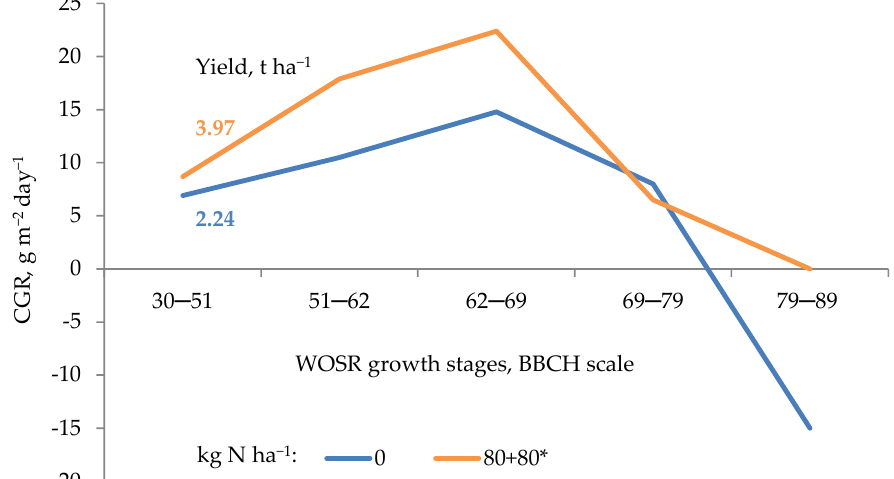
Figure 4. Crop growth rate (CGR) of winter oilseed rape (WOSR) during the growing season as affected by nitrogen fertilizer (based on Barł ó g and Grzebisz [22]). Key: CGR—crop growth rate, N–0—absolute control, N–80 + 80*–N rate of 160 kg N ha − 1 applied at the onset of the growing season restart in Spring; * ammonium nitrate; 30, 51, 62, 69, 79, 89—WOSR growth stages in BBCH scale.